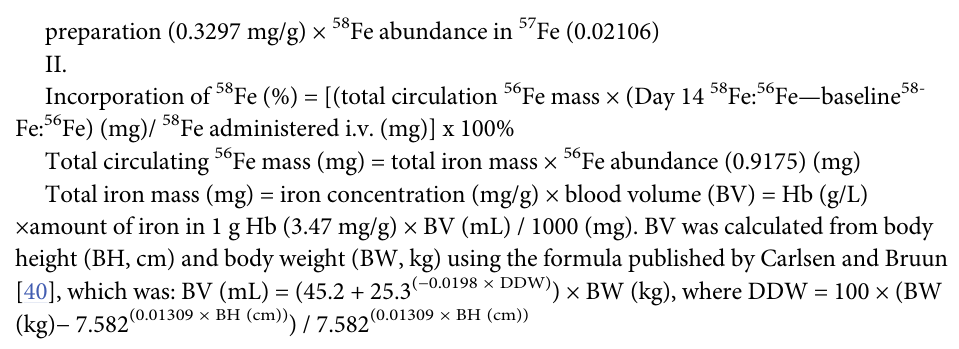
Table 2. Subject basic characteristics.